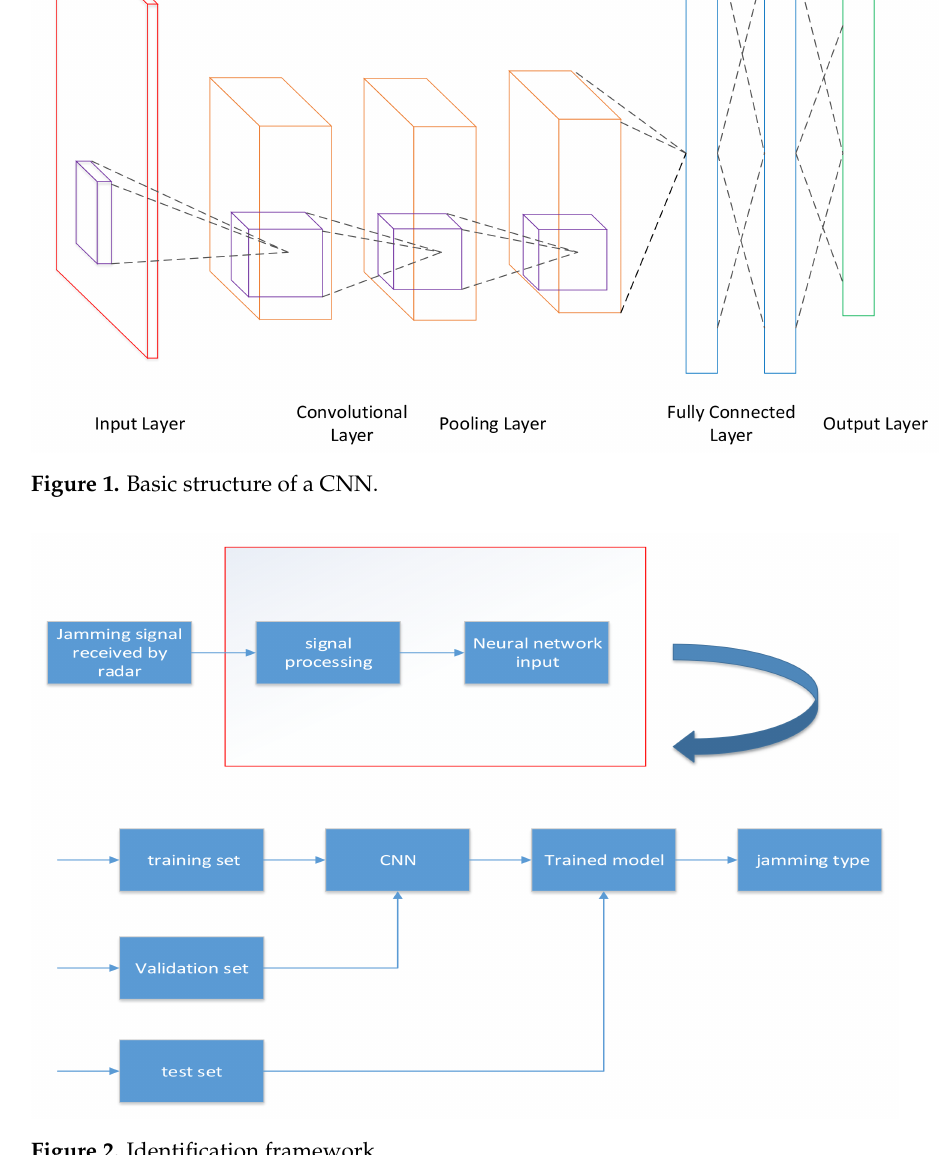
Figure 2. Identification